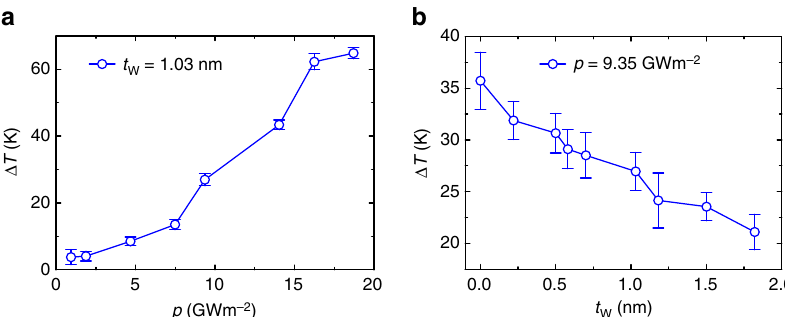
Figure 3 | Temperature rise in lipid bilayers on heat generation in graphene. ( a ) The rise in temperature, D T , in the lipid bilayer after heat flux with power density p is injected into graphene. A critical power density p c of B 7.5GWm (cid:2) 2 can be identified for a targeted threshold of temperature rise, D T c . Here we consider D T c ¼ 20K as an example for illustration. ( b ) Temperature rise in the lipid bilayer as graphene is heated at a power density of p ¼ B 9.35GWm (cid:2) 2 , plotted as a function of t W . Error bars are plotted based on results from five independent simulation